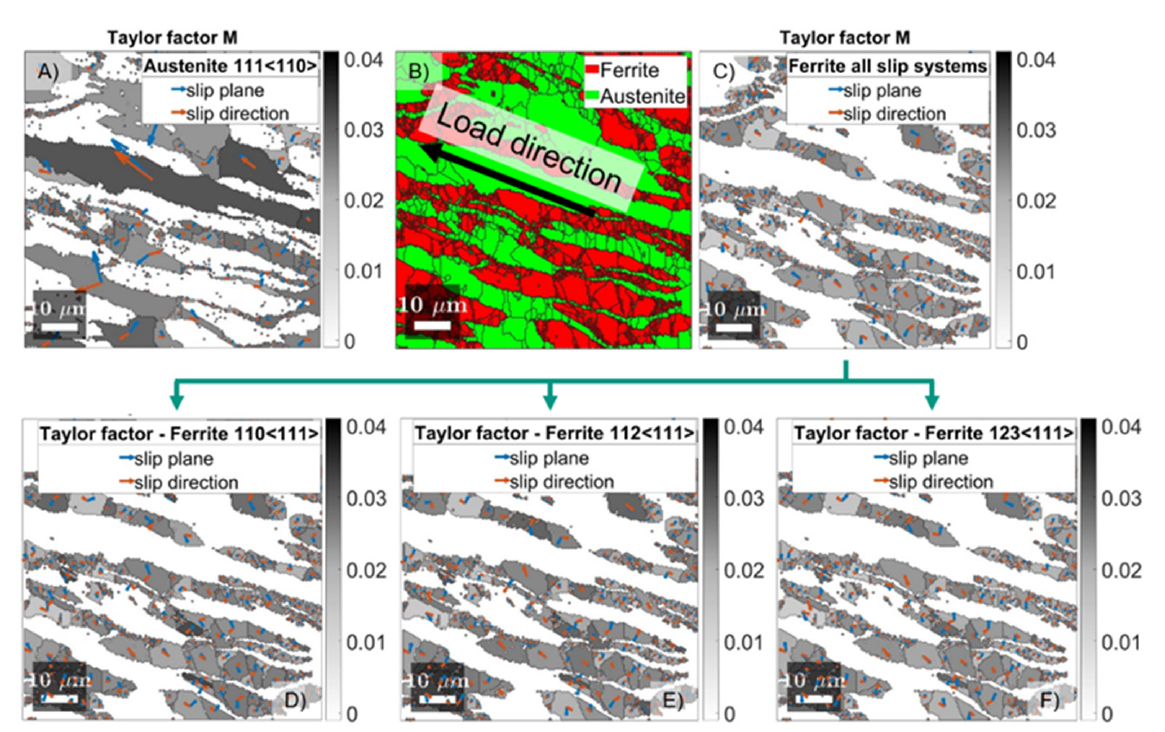
Figure 3. EBSD investigation of the 1.4462 duplex stainless steel and the Taylor factors derived from the EBSD data for the different slip systems. ( A ) The Taylor factor and the orientation of the slip system for the austenite phase.( B ) The phase distribution in the investigated area. The represented load direction corresponds to the load direction applied in the neutronographic in situ tensile test. For both phases, the Taylor factor M (global and {hkl}-specific) was determined using MTEX [31]. ( C ) The same for the ferrite phase. ( D – F ) Separate similar results for the three possible slip systems in the bcc ferrite phase.